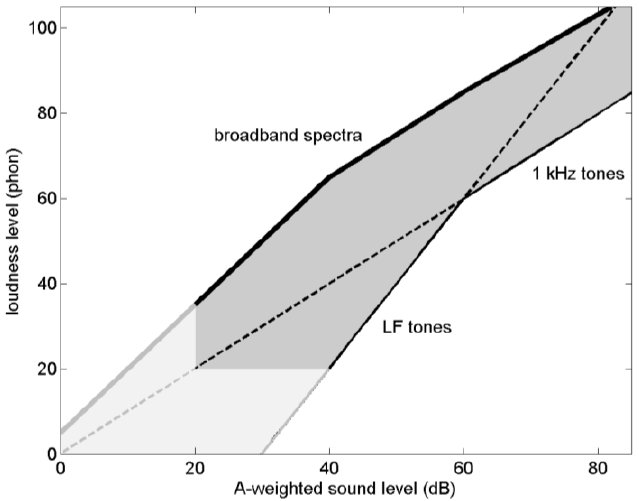
Figure 12. Schematic representation of Figure 11. The gray area represents the range of loudness levels of noise spectra in practice, and is bounded by the 0.3 power law for 1 kHz tones, the 0.6 power law for LF tones, and an upper curve for broadband